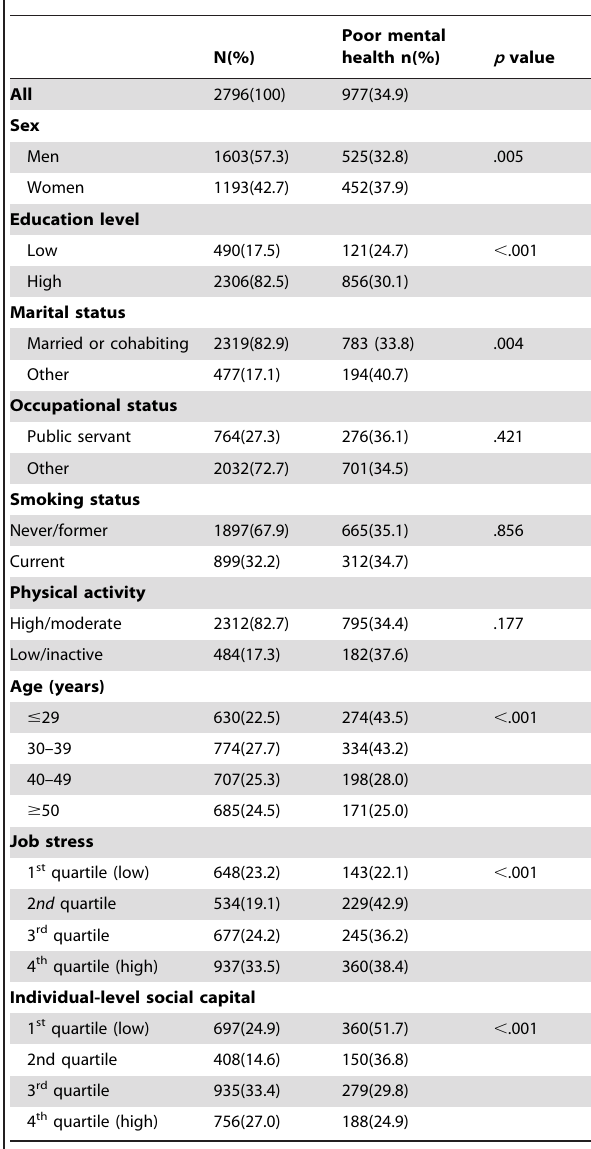
Table 1. Descriptive statistics for study